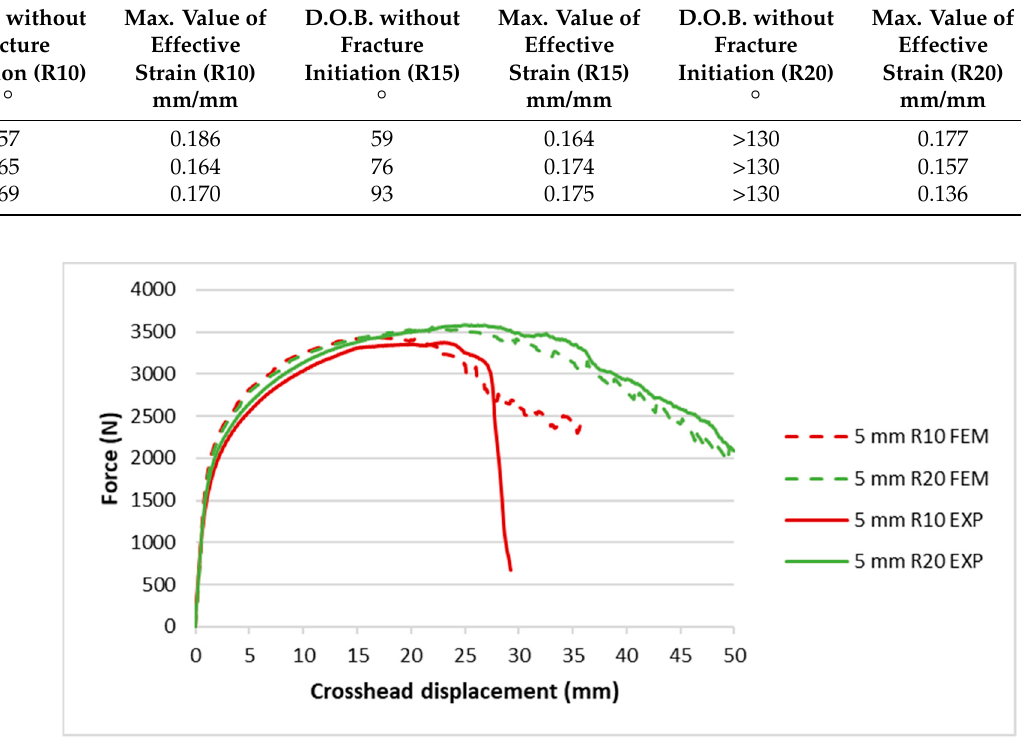
Figure 8. The correlation between FEM predicted and the experimentally measured relation between the force and the cross-head displacement for 4.5 mm sheet.